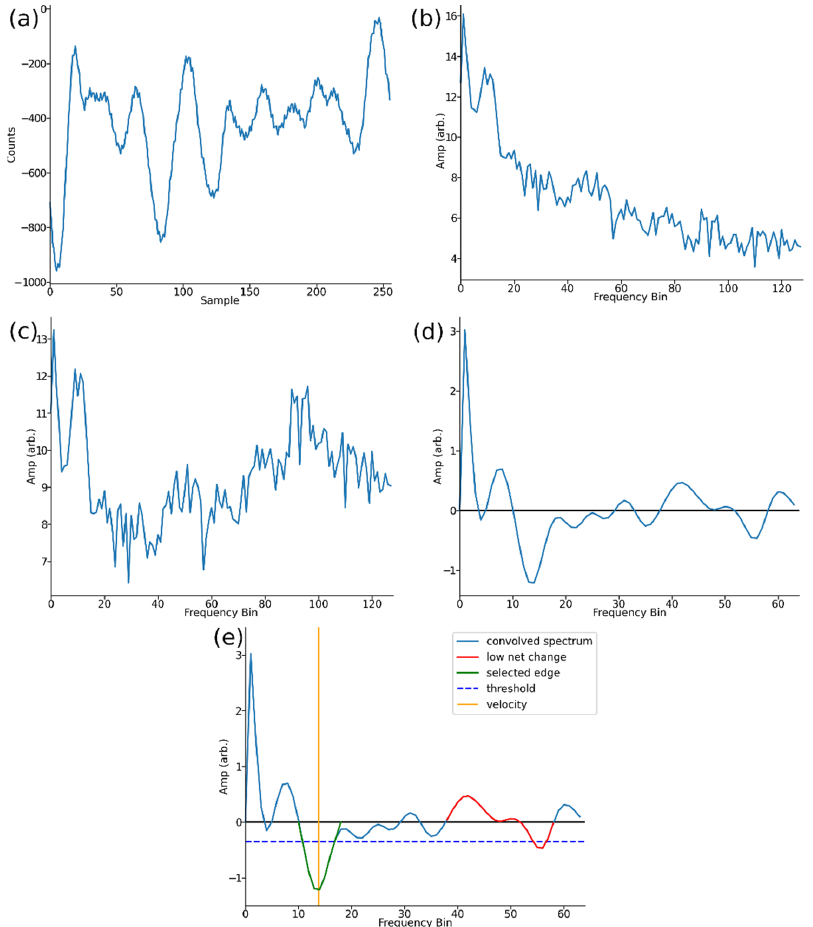
Figure 7. Signal waveform after points in digital signal processing pipeline: ( a ) raw s [ t ] captured data, ( b ) waveform after FFT accumulation and logarithm, ( c ) waveform after whitening, ( d ) waveform after convolution, and ( e ) waveform showing edge detection and final velocity reading. The edge detection threshold is shown in dashed blue, an edge rejected due to a low net change is shown in red, and the selected edge is shown in green. The orange vertical line displays the frequency bin corresponding to the final measured